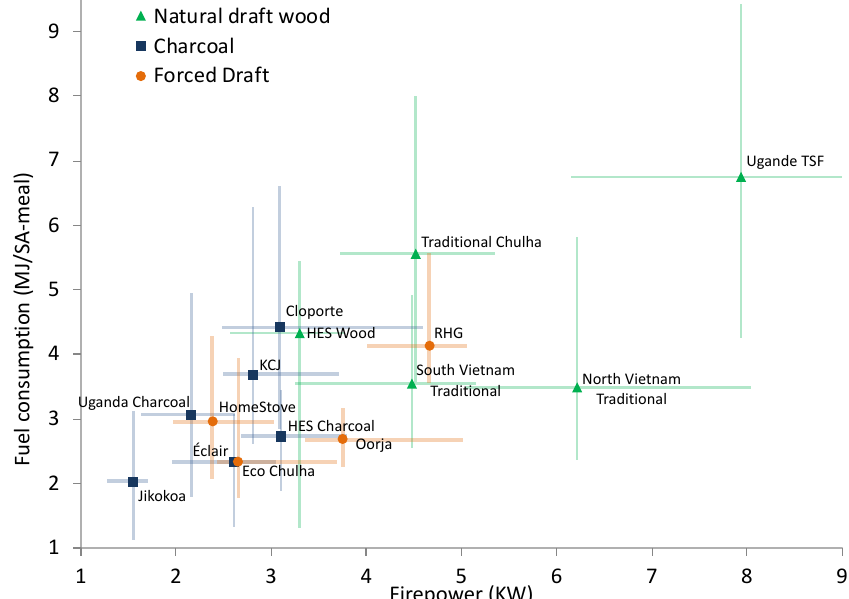
Figure 4. Median cookstove fuel consumption performance versus firepower. Error bars represent the IQR. Notes: LPG is not shown on the graph as meals were not prepared on the LPG stoves. LPG stove power had an IQR of 1.9–3.4 kW, with a median of 2.1 kW. The Eco Chulhas when used with pellets and wood were combined as they showed negligible di ff erence in power and fuel consumption